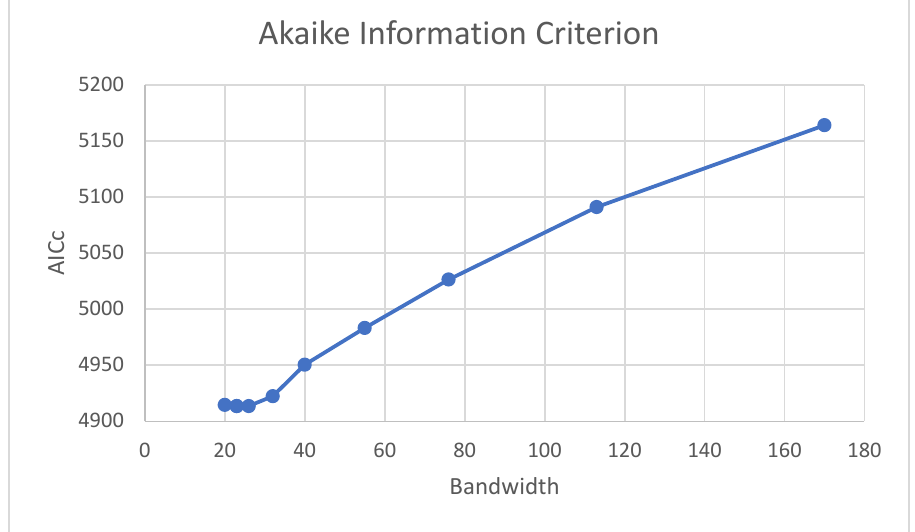
Figure 3. Bandwidth optimization for the GWR models. The AICc demonstrated a minimum using 23 neighbors as a bandwidth value.